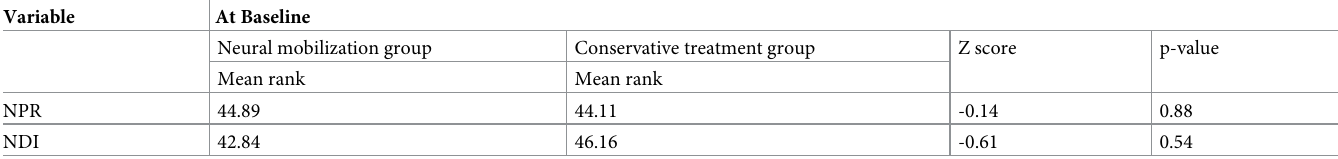
Table 1. Baseline measurement of pain (NPRS) and disability (NDI).